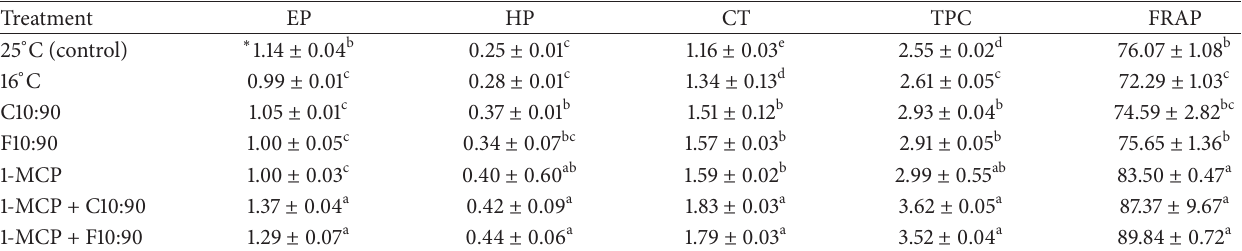
Table 3: Extractable polyphenols (EP), hydrolysable polyphenols (HP), condensed tannins (CT), total phenolic content (TPC) (GAE/100 g dry matter of edible food), and ferric reducing antioxidant power (FRAP, 𝜇 mol ET/g dry matter of edible food) of seedless pulp obtained from soursop stored at 25 ∘ C, 16 ∘ C, fruits with emulsions and stored at 16 ∘ C; fruits treated with 1-MCP and stored at 16 ∘ C; fruits treated with 1-MCP + emulsions and stored at 16 ∘